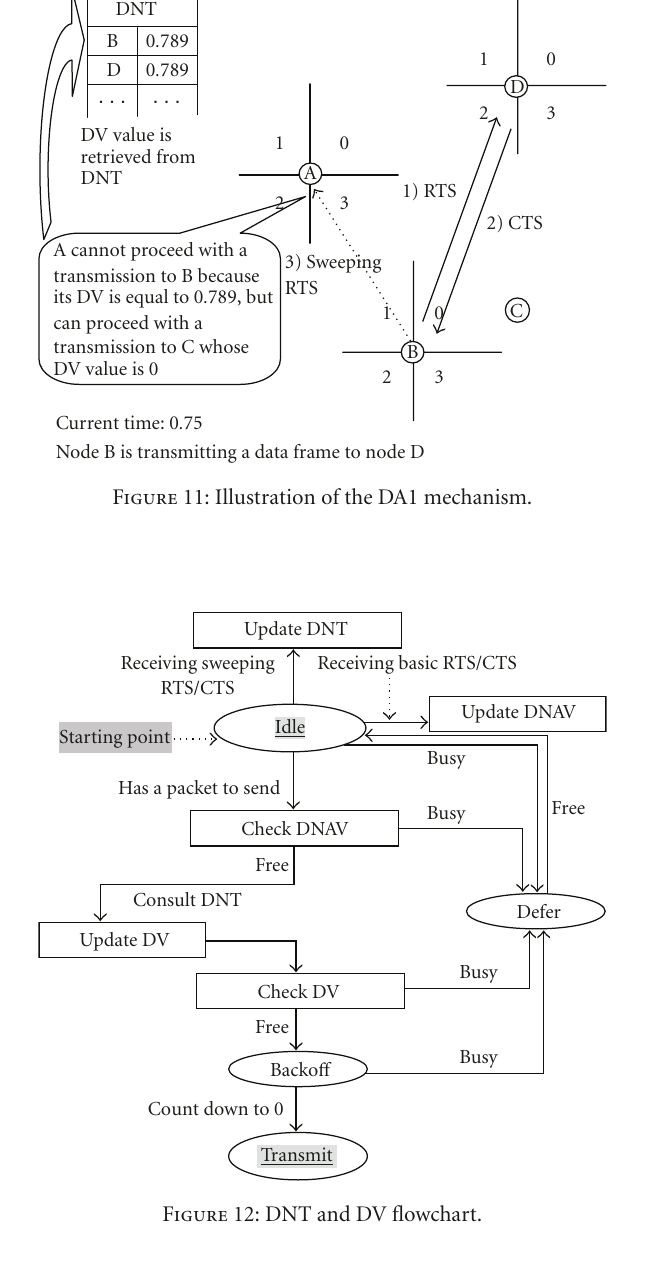
Table 1: DNT/DV versus